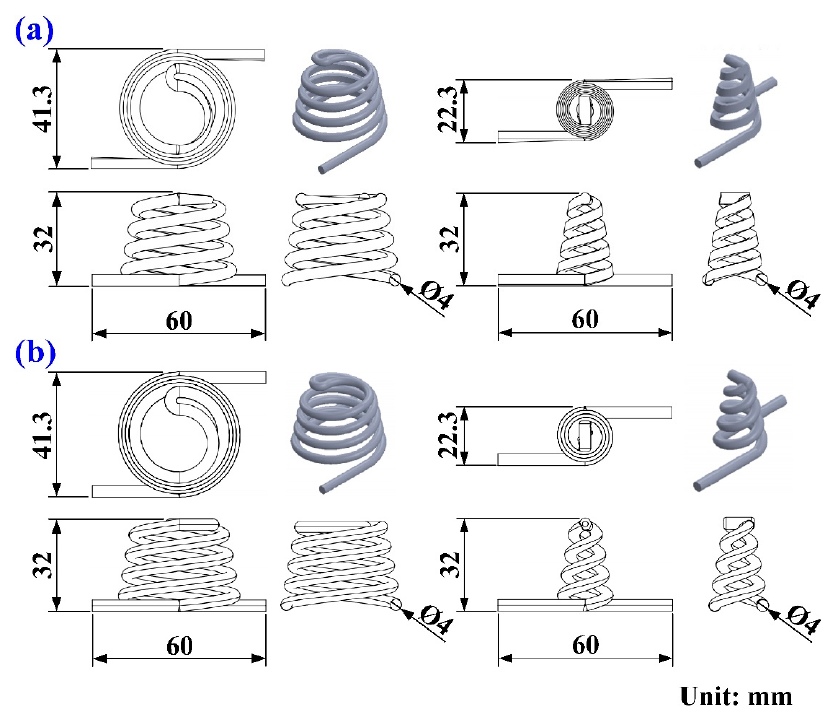
Figure 5. Layouts of ( a ) PCCC and ( b ) CCCC.